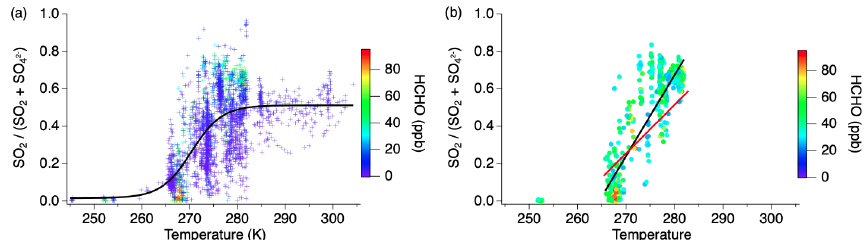
Figure 6. Fractional sulfur conversion as a function of temperature (a) including all smoke ages with a sigmoid fit and (b) only measurements with HCHO > 25ppb with the black line indicating the linear fit through the data at all ages between 265–283K and the red line indicating the linear fit through the measurements within 1h of emission in the same temperature regime.